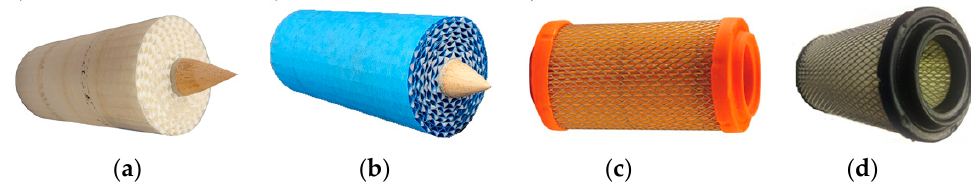
Figure 12. Test filters prepared for testing: ( a ) PowerCore filter—PC, ( b ) PowerCore G2 filter—G2, ( c ) filter with cellulose bed—C, ( d ) filter with polyester bed—P (photos taken by the author).